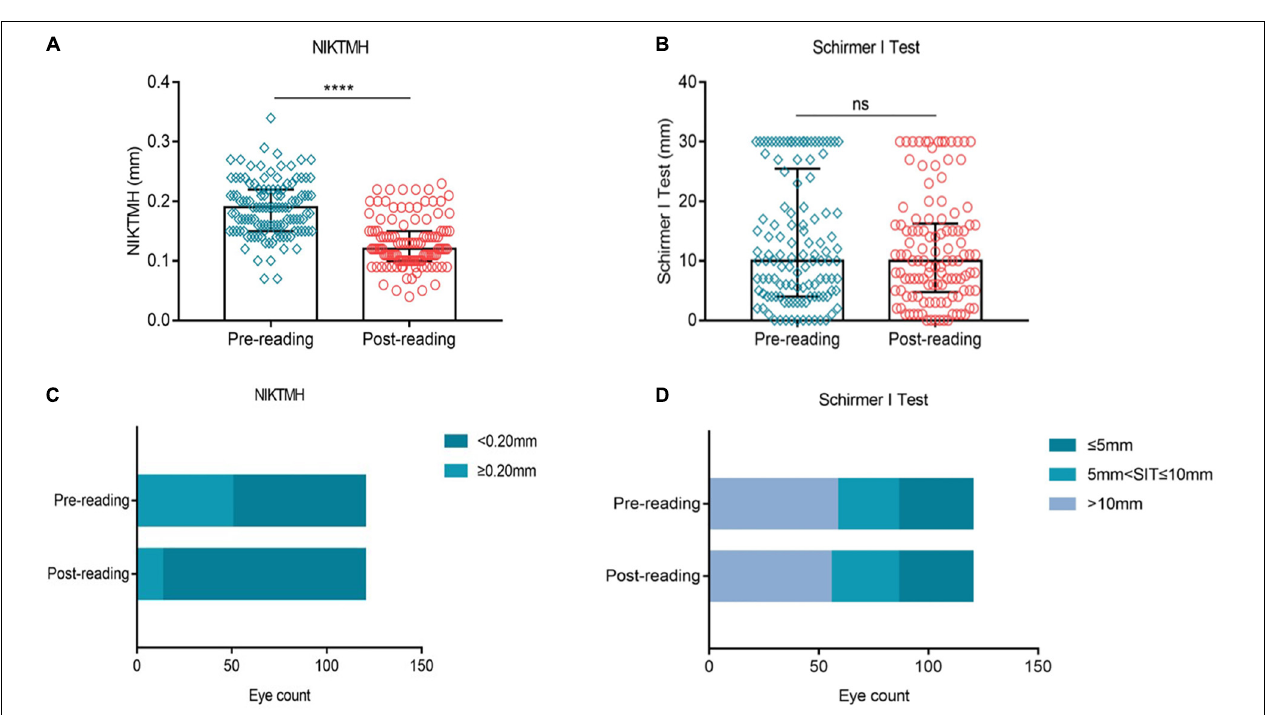
FIGURE 3 | Effects of continuous smartphne reading for 2 h on tear film stability. NIBUT-First (A) , NIBUT-Average (B) and FBUT-Average (C) decreased significantly compared to the baseline level, while the proportion of BUT ≤ 5 s increased significantly (D–F) . (A–C) Dates are presented as median and interquartile range, **** p ≤ 0.0001.